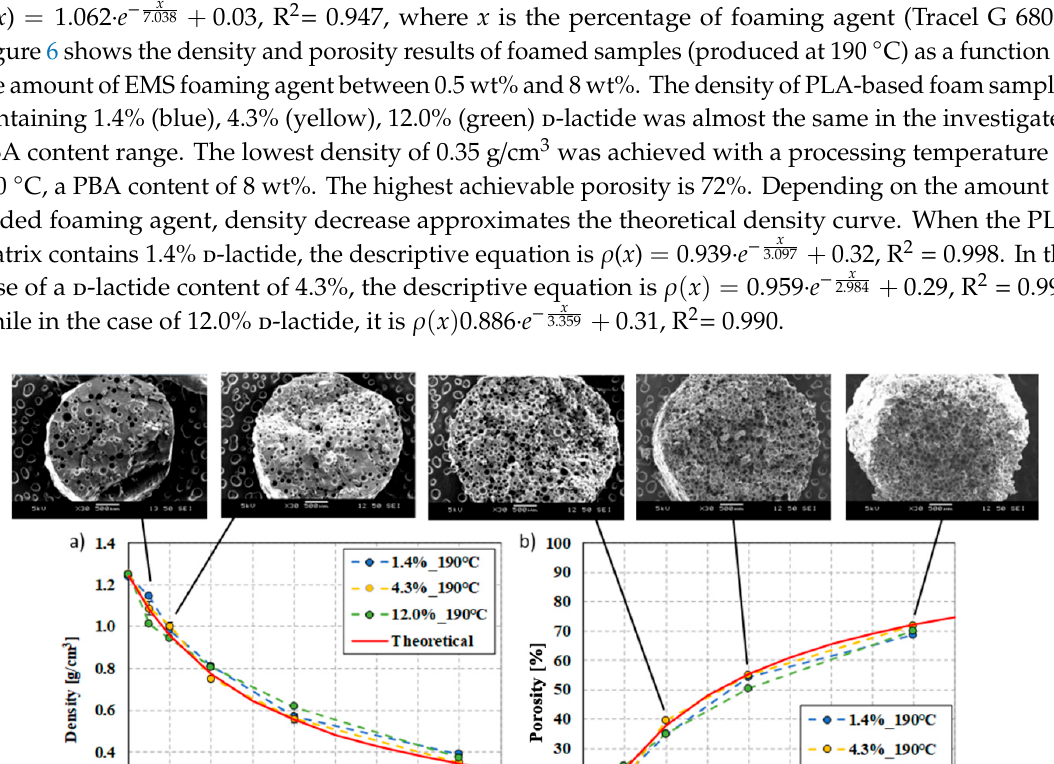
Figure 5. ( a ) The color of the produced foam structures at 190, 210, and 230 °C; ( b ) foam structure surface at 190 °C with 4.3% D -lactide content and with 8 wt% EMS.